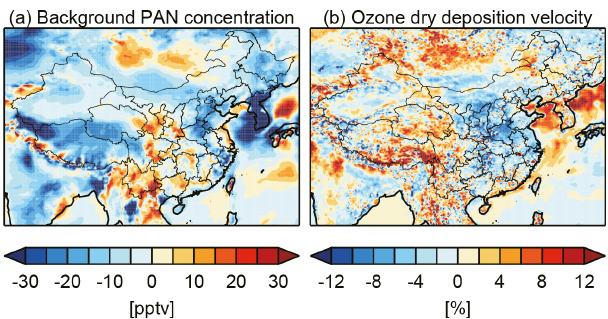
Figure 14. Differences in May–August mean (a) background PAN concentration and (b) ozone dry deposition velocity between 2017 and